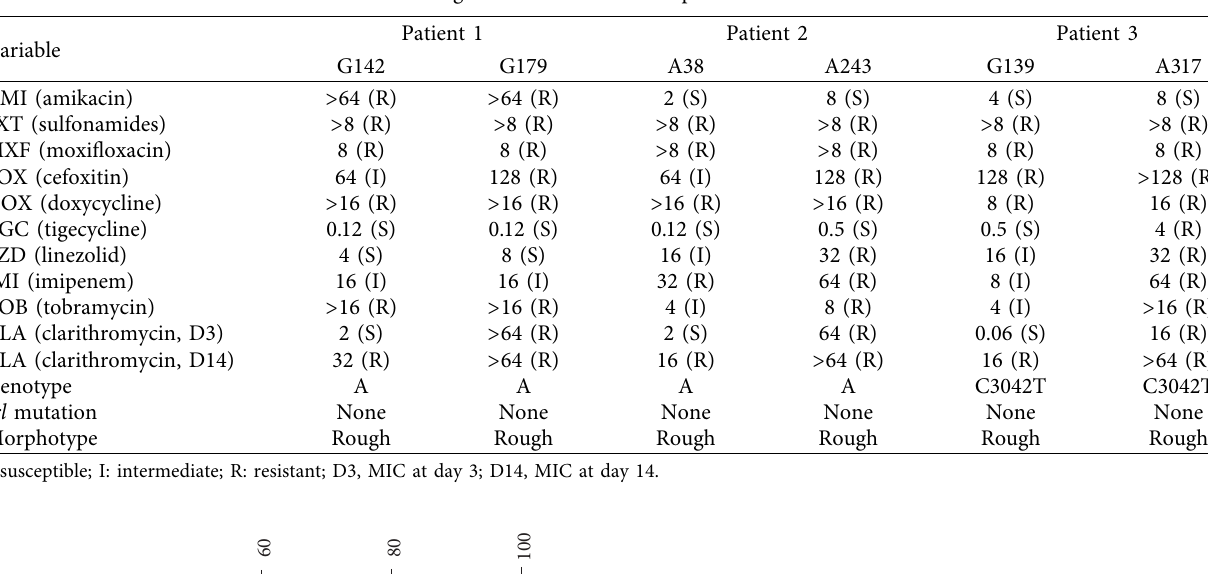
Table 2: Microbiological characteristics of 6 paired M. abscessus